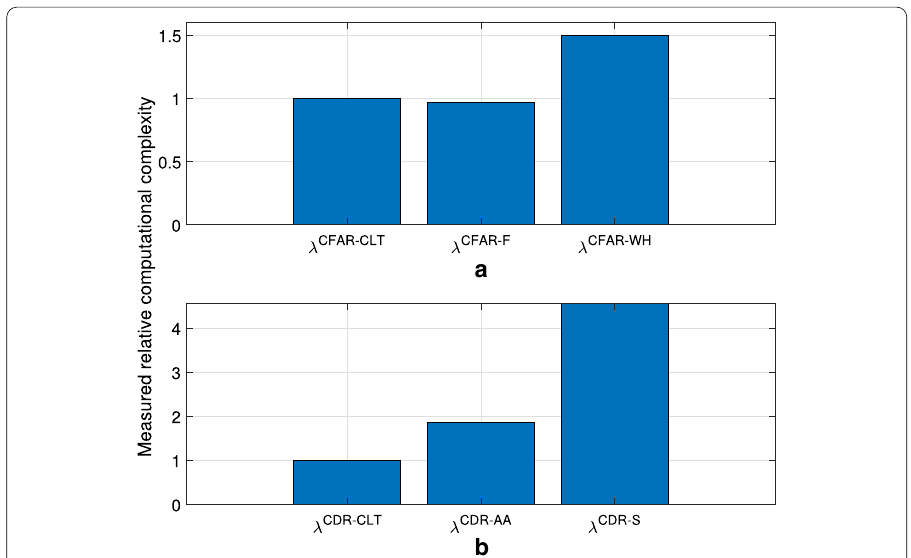
Fig. 5 Measured relative computational complexity comparison between the proposed fixed threshold schemes. CFAR expressions are compared in a . CDR expressions are related in